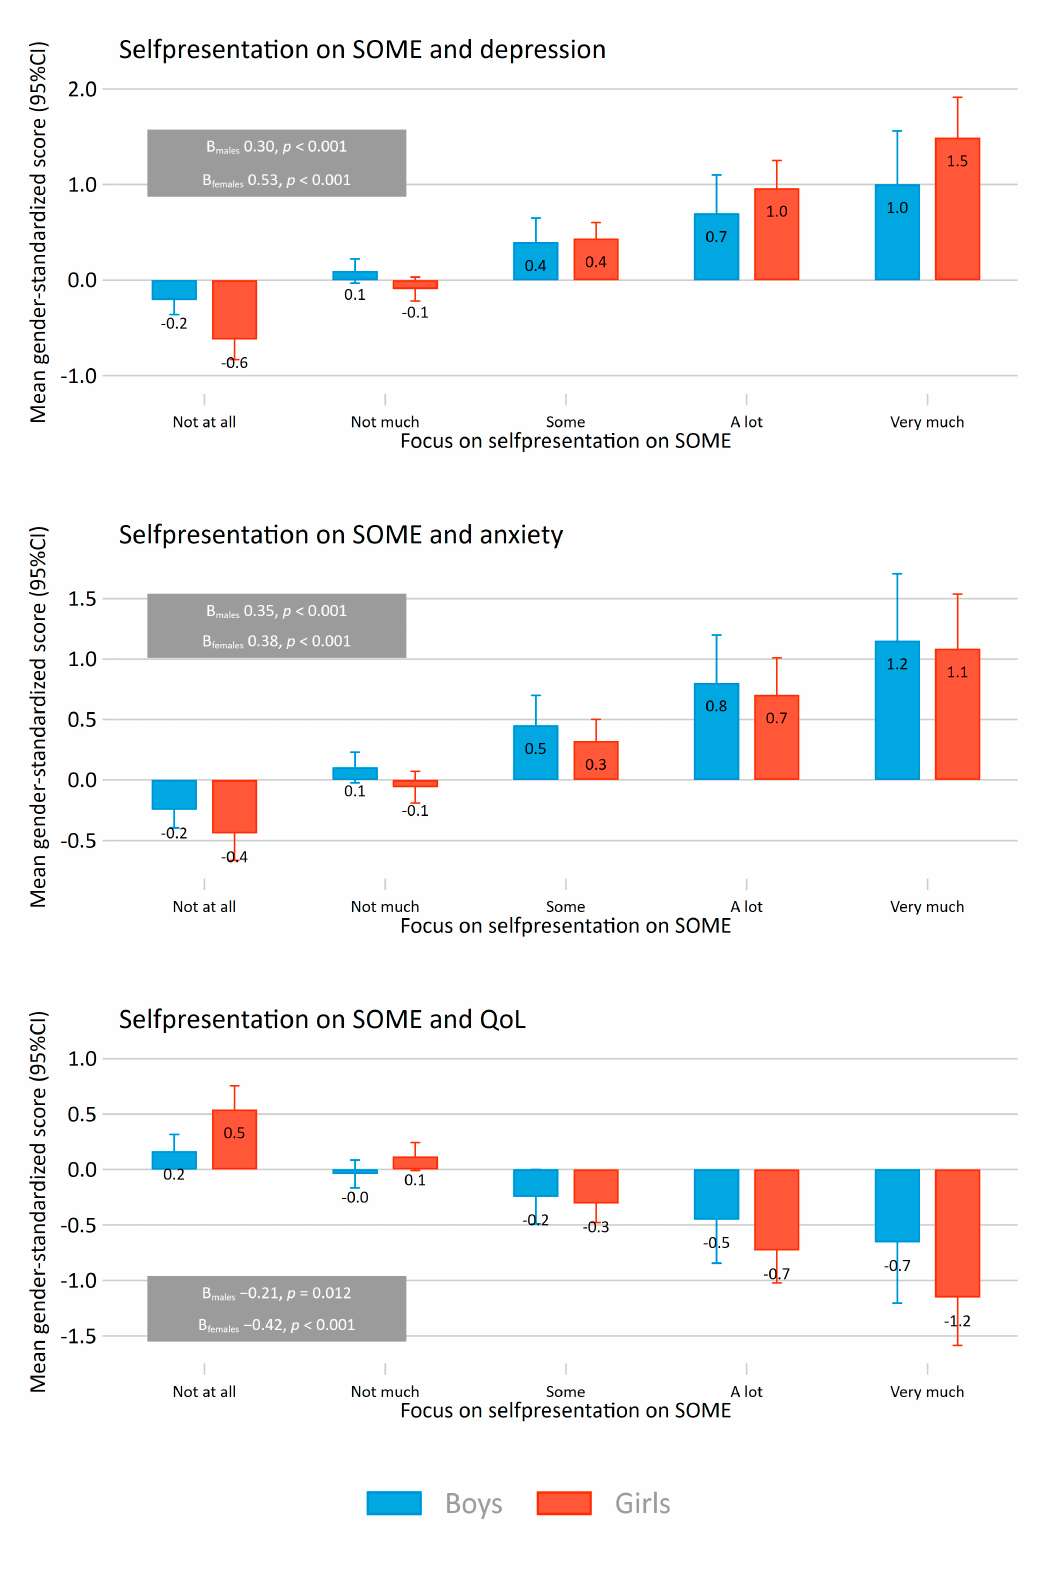
Figure 2. Associations between quality of life, depression and generalized anxiety, and self-reported focus on self-presentation on social media. Gender-stratified. Bars denote predicted deviation from gender-specific mean for symptoms of depression and anxiety and quality of life with 95% confidence intervals. Standardized score for average gender-specific coefficients (trend) in